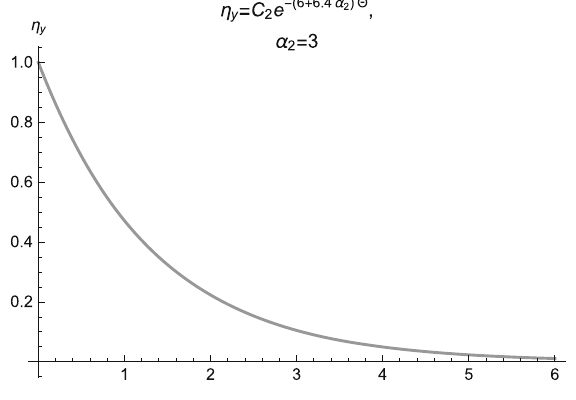
Fig. 19 Variation of η y with respect to (cid:16) for S at γ = 0